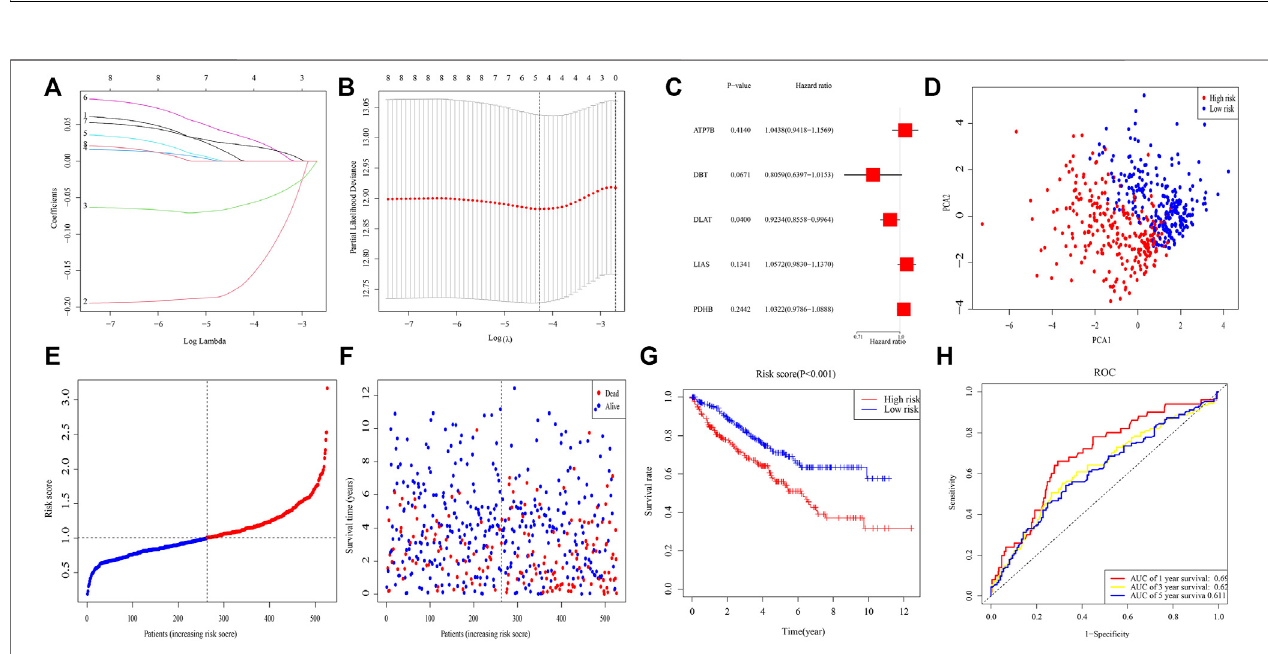
FIGURE 2 | Risk signature in TCGA. (A) Lasso regression analysis of eight genes. (B) Cross-validation of results of lasso regression analysis. (C) Multivariable Cox regression analysis of genes determined by lasso regression analysis. (D) PCA plot of patients with ccRCC. (E) Distribution of ccRCC patients based on risk scores. (F) Distributions of OS status, OS, and risk scores. (G) KM curves for OS of ccRCC patients in different clusters. (H) ROC curves of this signature.